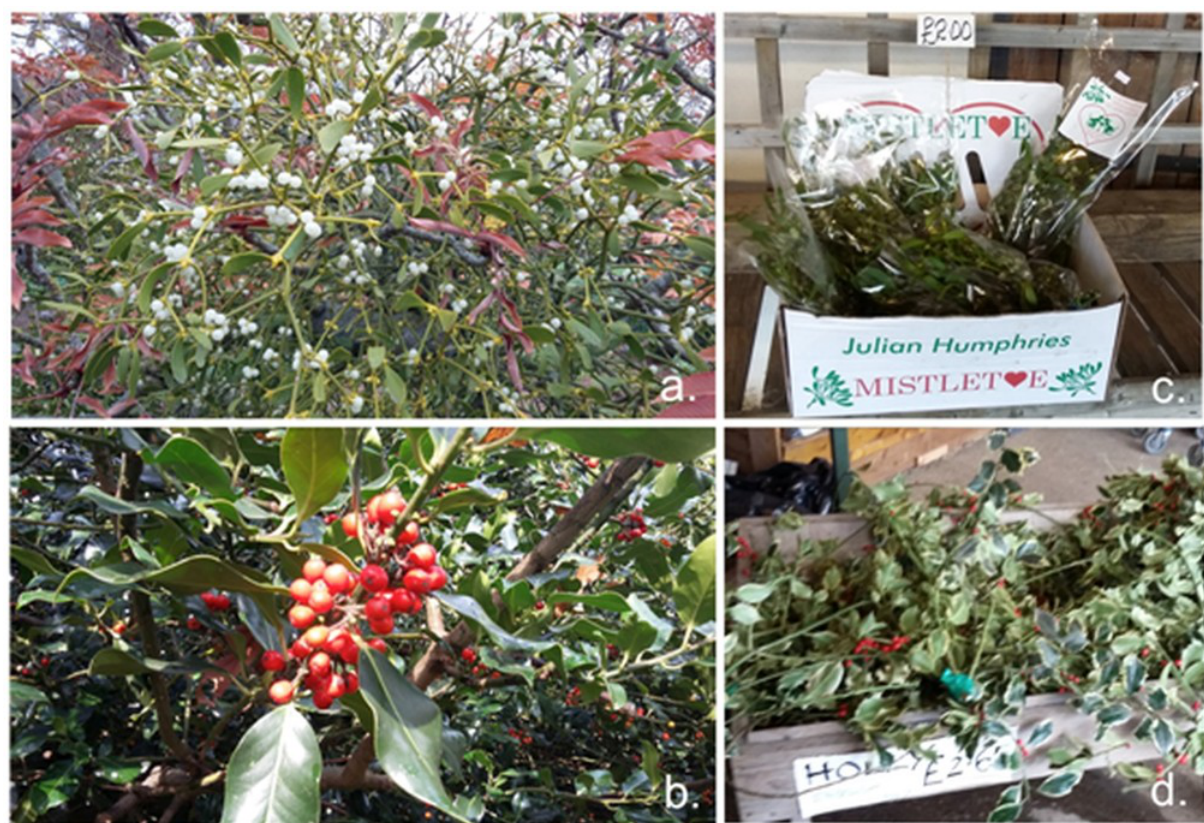
F IGURE 1: (A) Mistletoe and (B) holly berries growing on female plants in situ, and the same species packaged displayed for retail (C & D) Photos by J.